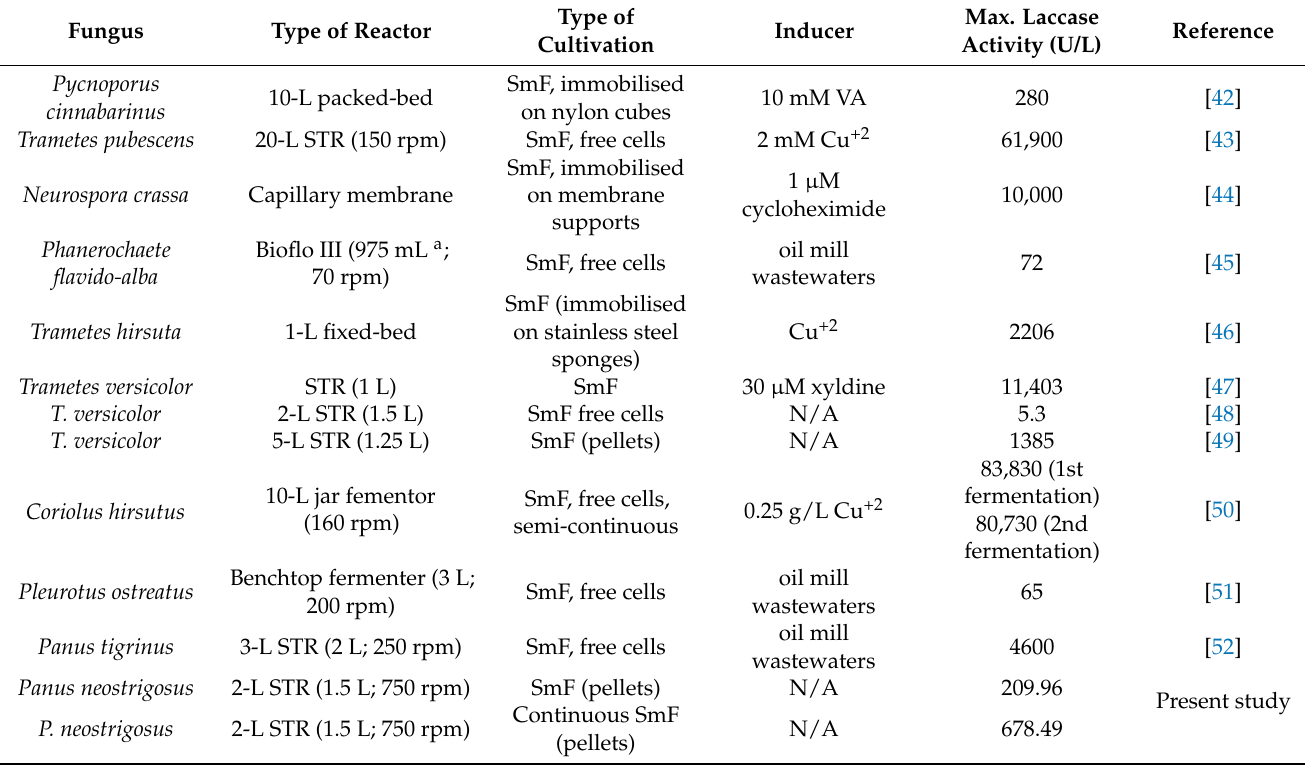
Table 8. Maximum laccase activities obtained from different filamentous fungi at bioreactor